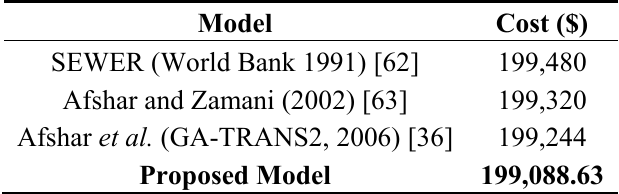
Table 3. World Bank (1991) case study. Optimal results obtained by various researchers.